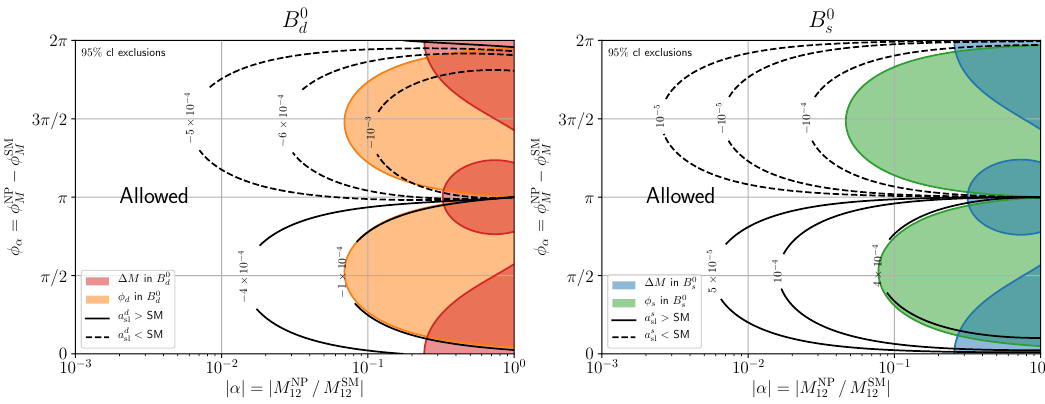
Figure 1. Bounds on the NP contributions to the absolute value (horizontal axis) and the phase (vertical axis) of M 12 , assuming (cid:0) 12 is given by the SM value. The left panel corresponds to the B 0 system, and the right panel to B 0 . Colored contours are excluded by measurements of (cid:1) M and s d mixing-induced CP violation. The contour levels give the values of the semileptonic asymmetry, with solid (dashed) lines corresponding to values larger (smaller) than the SM